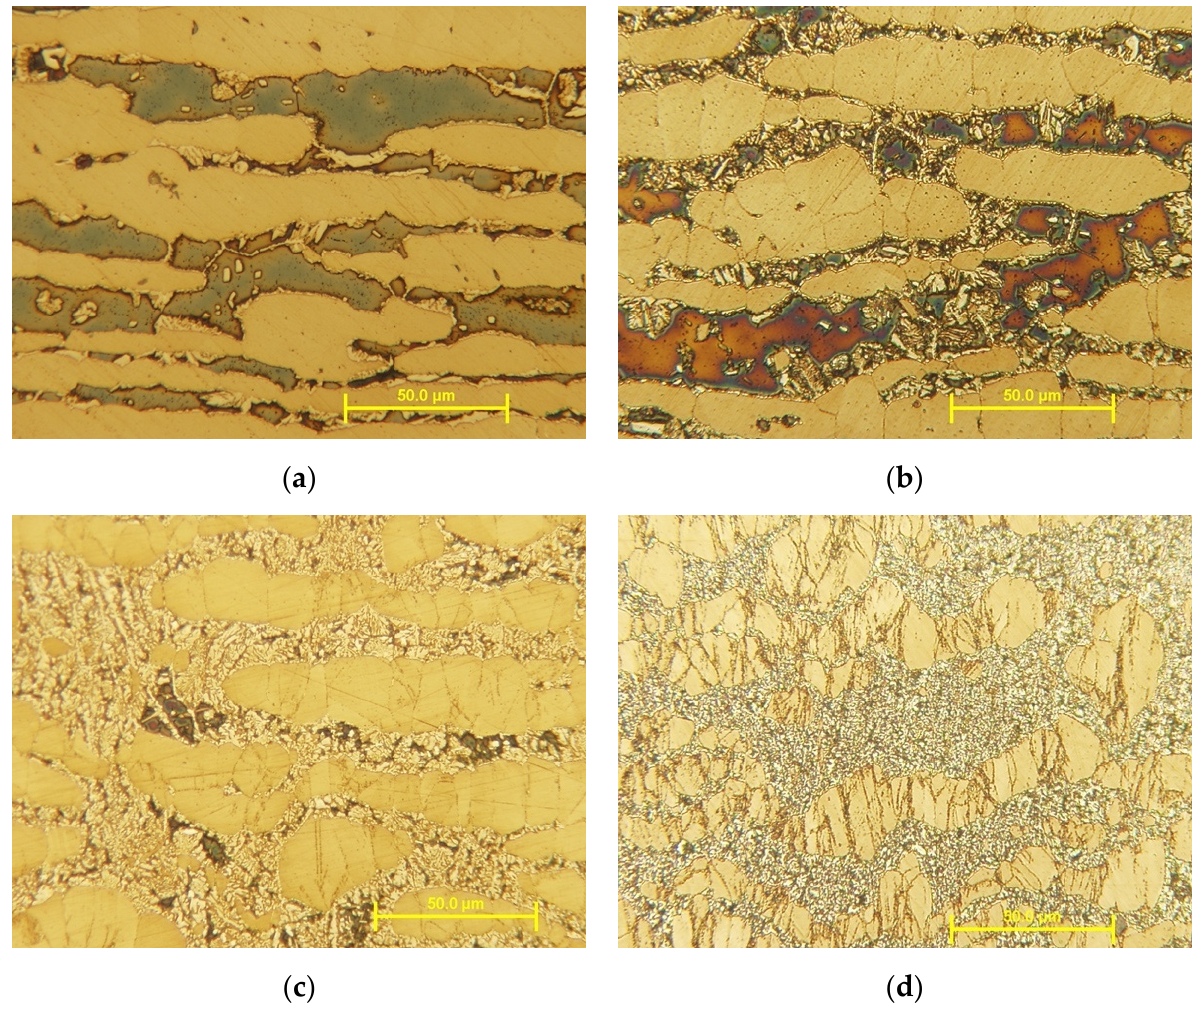
Figure 2. Optical microscopic images of tested DSS specimens after heat treatment at 850 °C for 30 min. ( a ) No deformation; ( b ) 22.3% rolling reduction; ( c ) 41.6% rolling reduction; ( d ) 6.9% rolling reduction.